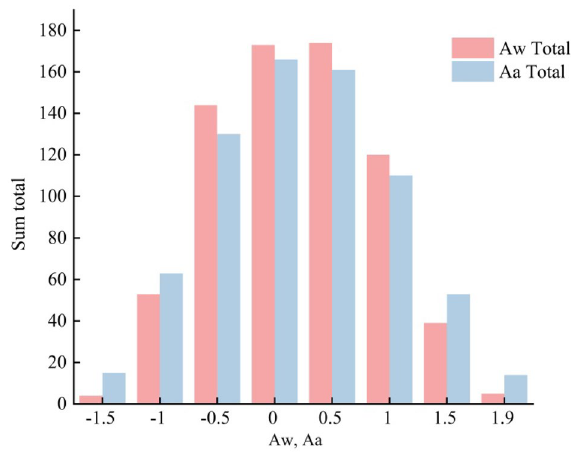
Figure 2. Distribution characteristics of the RCA.